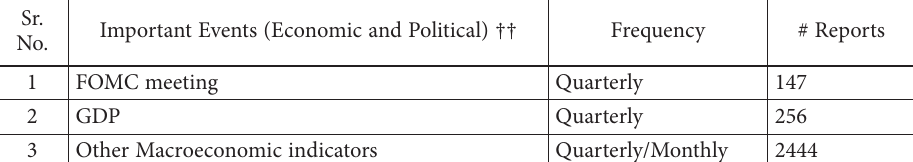
Table A.2. Description of scheduled macroeconomic announcements Sr.